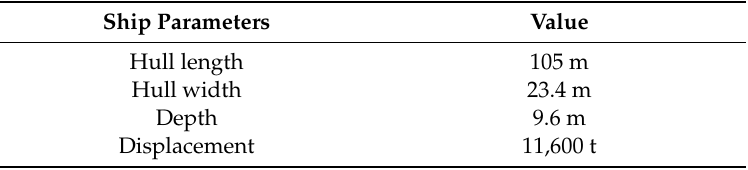
Table 3. Engineering ship parameters.